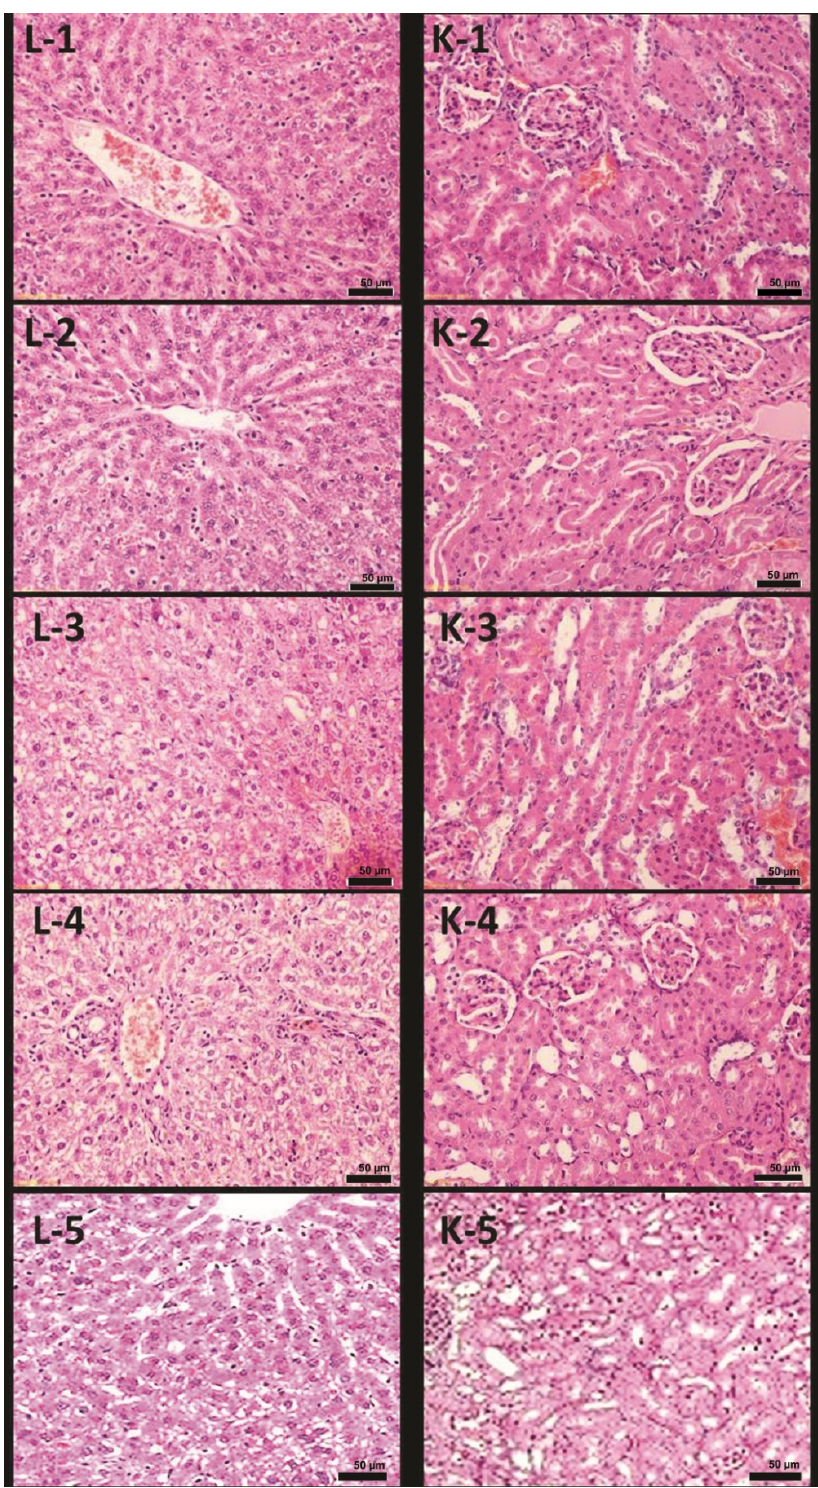
Figure 3. H and E-stained microscopic images of rats’ hepatic ( L ) and renal ( K ) tissues in the groups under study. 1 : the negative control group (group 1); 2 : the positive control group (group 2); 3 : the low-dose-SWE-treated group (group 3); 4 : the high-dose SWE-treated group (group 4); and 5 : the SWE/NCT-treated group (group